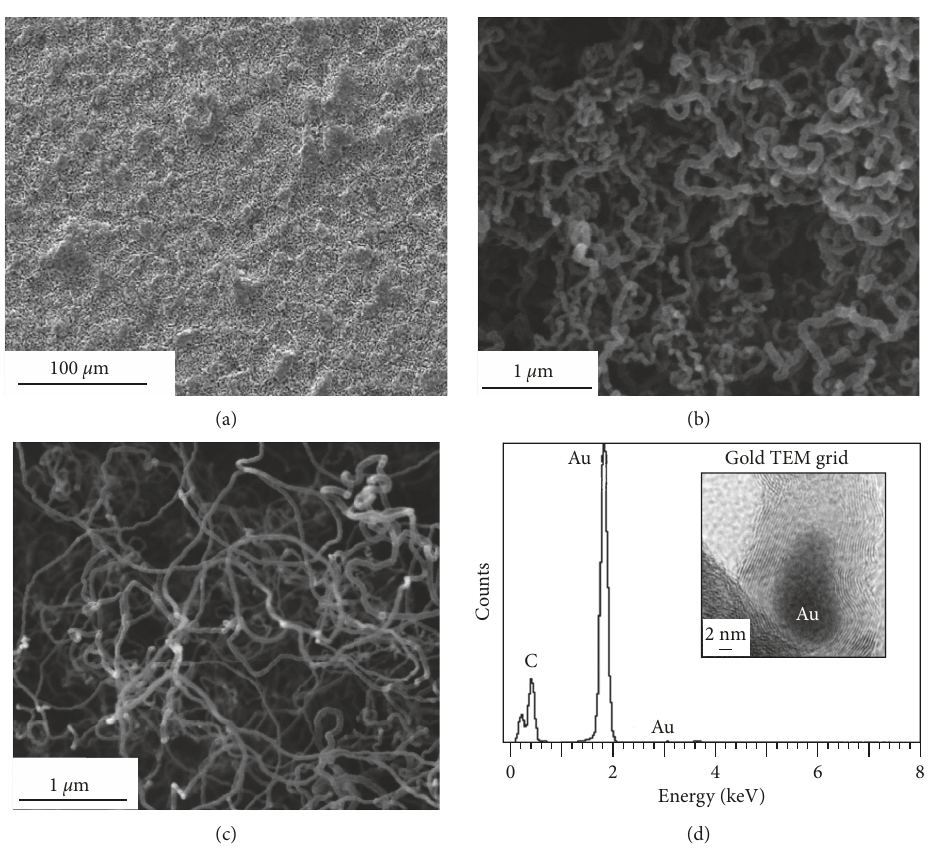
Figure 5: SEM images of MWCNTs grown using different growth temperatures with Au nanoparticles as catalysts: (a) 880 ° C, (b) 900 ° C, and (c) 950 ° C. (d) EDS signals of MWCNT with an Au catalyst particle under TEM.